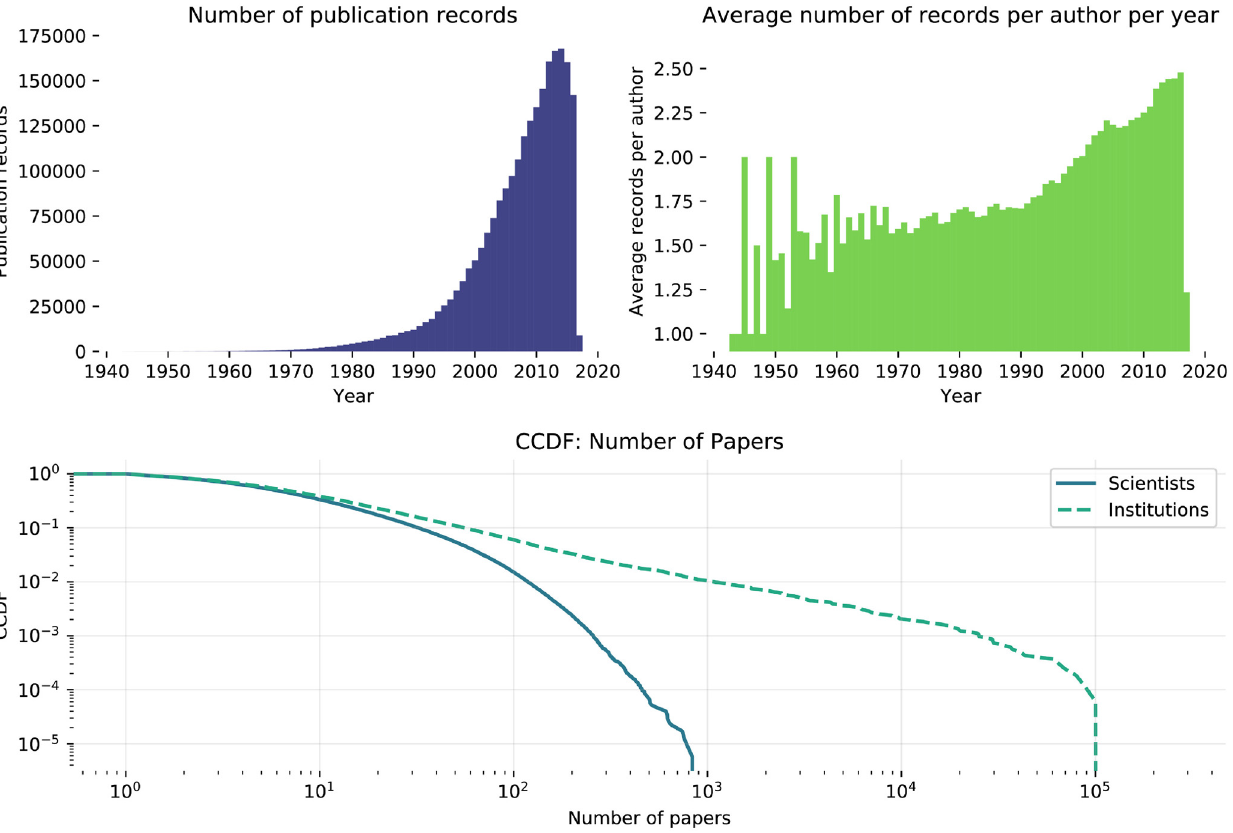
Fig 2. Data characterization. Top left : yearly number of new publication entries (a publication is counted multiple times if it is listed under more than one profile). This metric has been increasing since the mid-90s; decrease in last couple of years may be due to right-censoring. Top right : yearly number of publications entries normalized by number of authors. Between 1990 and 2016, this number has increased nearly 50%. Bottom : Complementary Cumulative Distribution Function (CCDF) of the number of publications per scientist and institution. Both distribution are heavy tailed, but the distribution for institutions seems to follow a power law with cutoff at x = 10 5